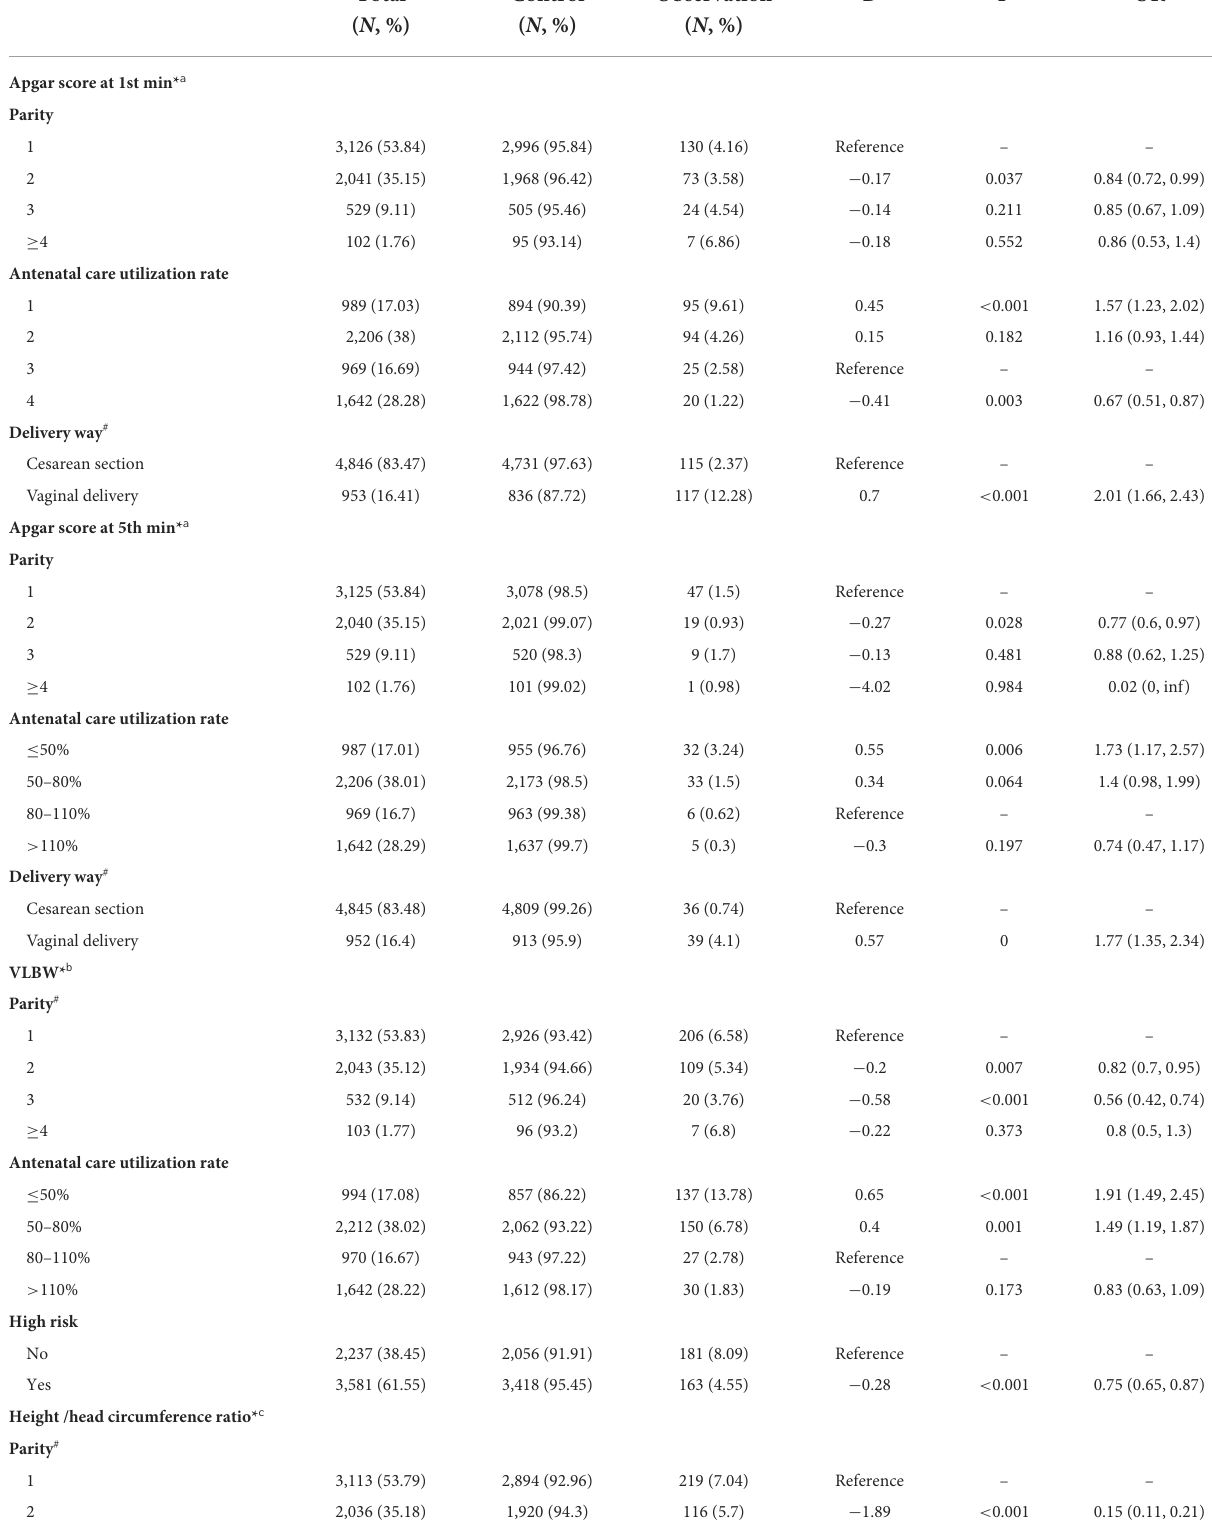
Total Control ( N , %) ( N , %)